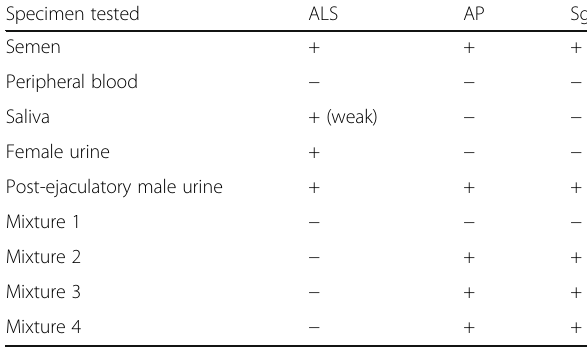
Table 2 Specificity of three semen detection